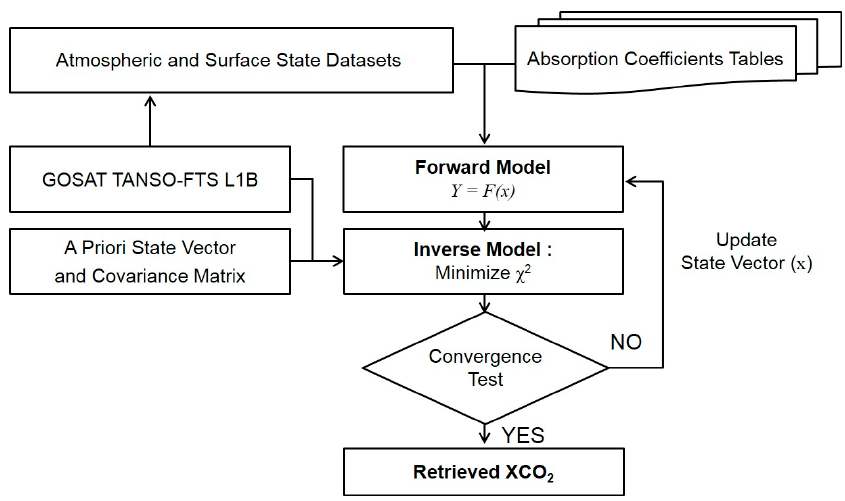
Figure 1. The flow chart of the Yonsei CArbon Retrieval (YCAR) algorithm. Table 1. The spectral band used in the YCAR algorithm.